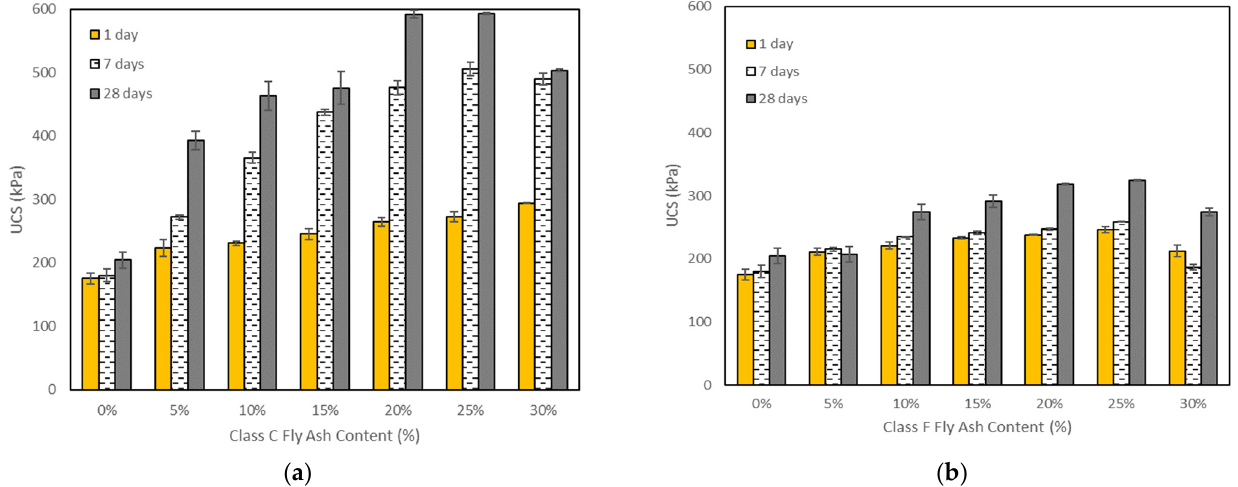
Figure 7. Effects of ( a ) class C and ( b ) class F fly ash contents on unconfined compressive strength with 1 day, 7 days, and 28 days of curing.